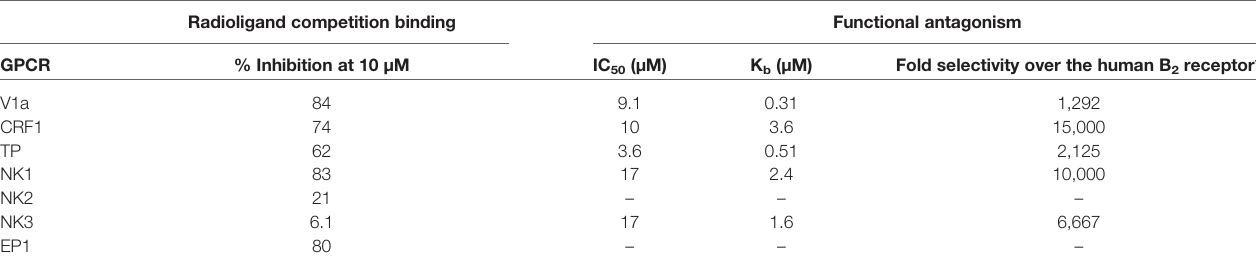
TABLE 8 | In vitro target pro fi le of Compound 3. Radioligand competition